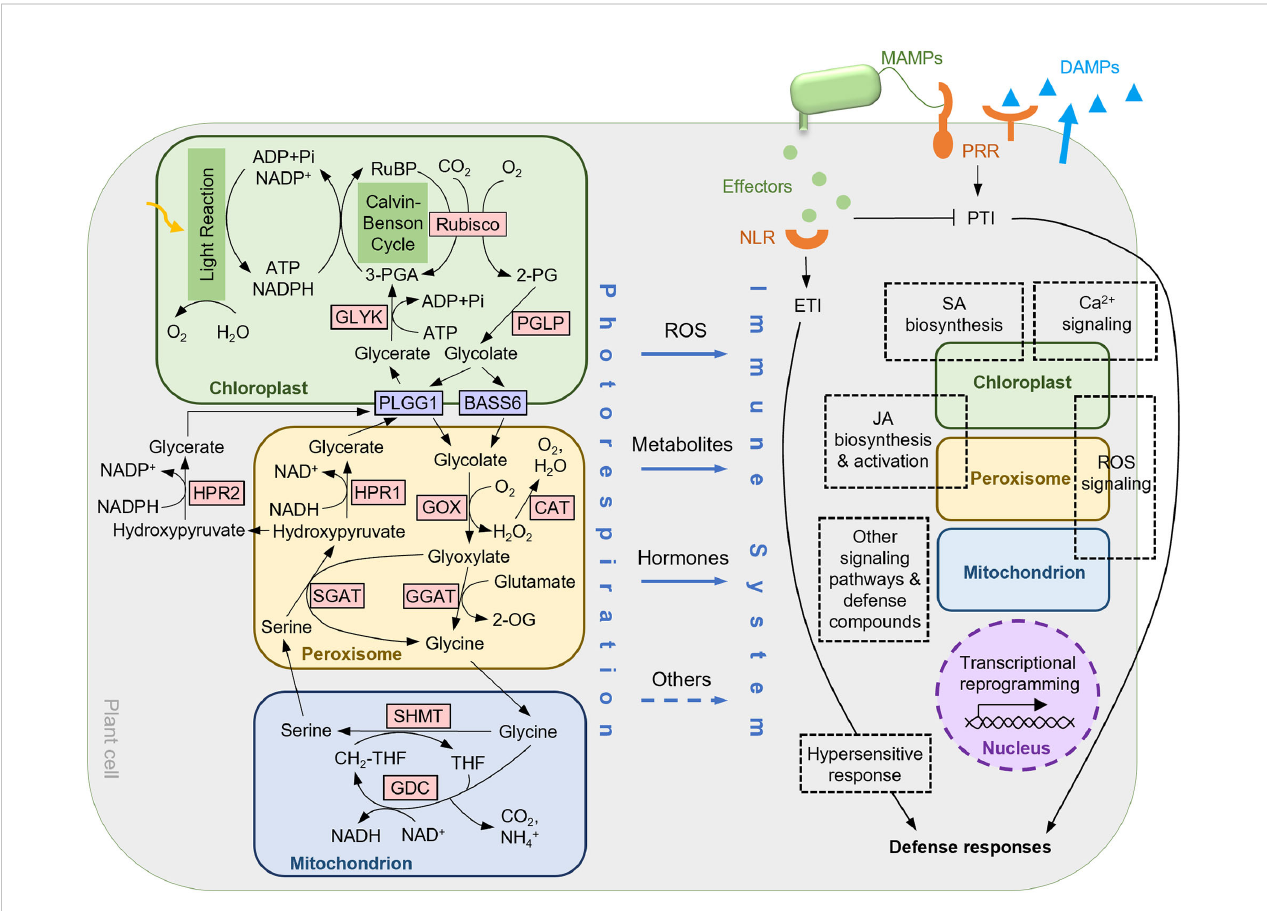
FIGURE 1 A working model for the connections between photorespiration and plant immunity. ROS, photorespiratory metabolites, defense hormones, and possibly other mechanisms connect the photorespiratory pathway to key components of the immune network. See main text for detailed information of the photorespiratory pathway and plant immunity, as well as mechanisms/potential mechanisms for their connections. Overlaps between some subcomponents of the immune response network and the photorespiratory organelles indicate the involvement of the particular organelles. 2-OG, 2- oxoglutarate; 2-PG, 2-phosphoglycolate; 3-PGA, 3-phosphoglycerate; BASS6, bile acid sodium symporter 6; CAT, catalase; GGAT, glutamate:glyoxylate aminotransferase; GDC, glycine decarboxylase complex; GLYK, glycerate kinase; GOX, glycolate oxidase; HPR, hydroxypyruvate reductase; PGLP, 2-PG phosphatase; PLGG1, plastidial glycolate/glycerate transporter 1; Rubisco, RuBP carboxylase/oxygenase; RuBP, ribulose-1,5-bisphosphate; SGAT, serine: glyoxylate aminotransferase; SHMT, serine hydroxymethyltransferase; THF, tetrahydrofolate; MAMP, microbe-associated molecular pattern; DAMP, damage-associated molecular pattern; PRR, pattern recognition receptor; NLR, nucleotide-binding/leucine-rich-repeat receptor; PTI, pattern-triggered immunity; ETI, effector-triggered immunity; ROS, reactive oxygen species; SA, salicylic acid; JA,